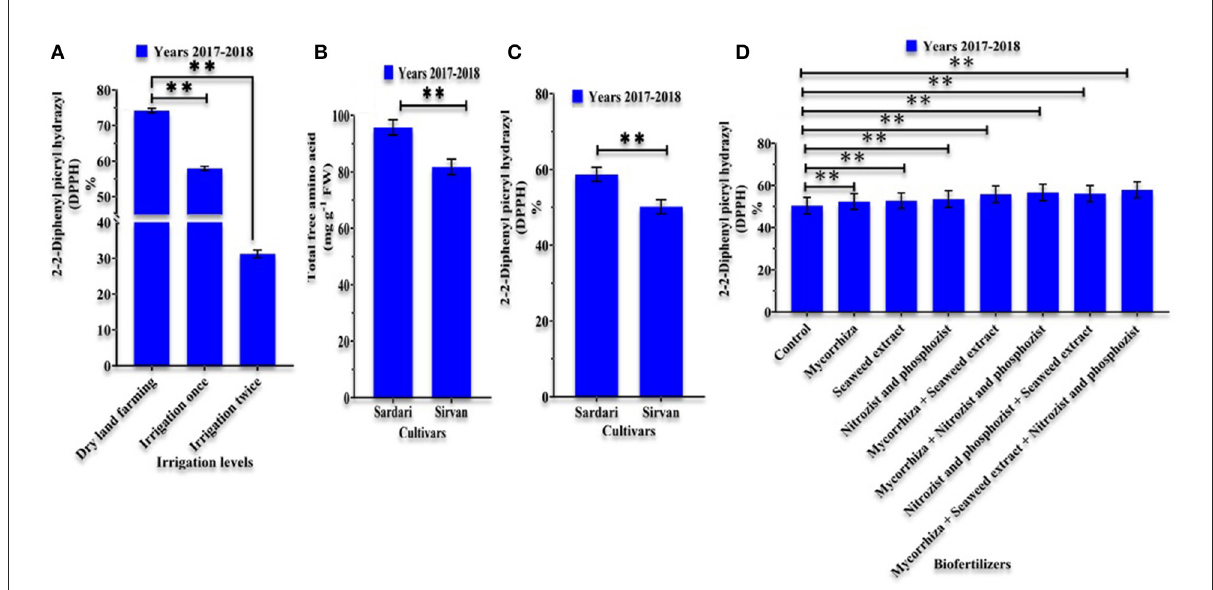
FIGURE5 Mean comparisons of main effects of irrigation levels (A) on 2-2-Diphenyl picryl hydrazyl (DPPH), mean comparisons of main effects of cultivars (B,C) on total free amino acids and 2-2-Diphenyl picryl hydrazyl (DPPH) and Mean comparisons of main effects of bio-fertilizers (D) on